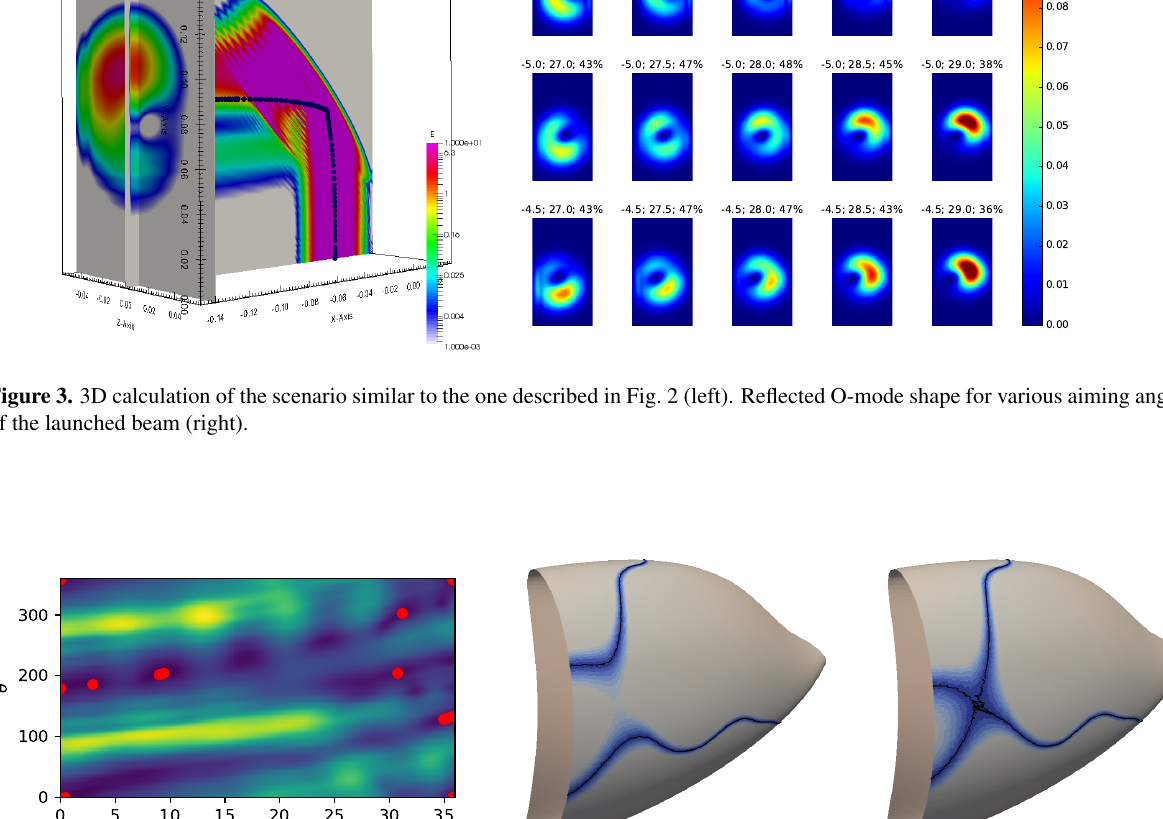
≈ 0 . 5632 ( φ ≈ 3 . 5 and θ ≈ 190 on the left plot). ||